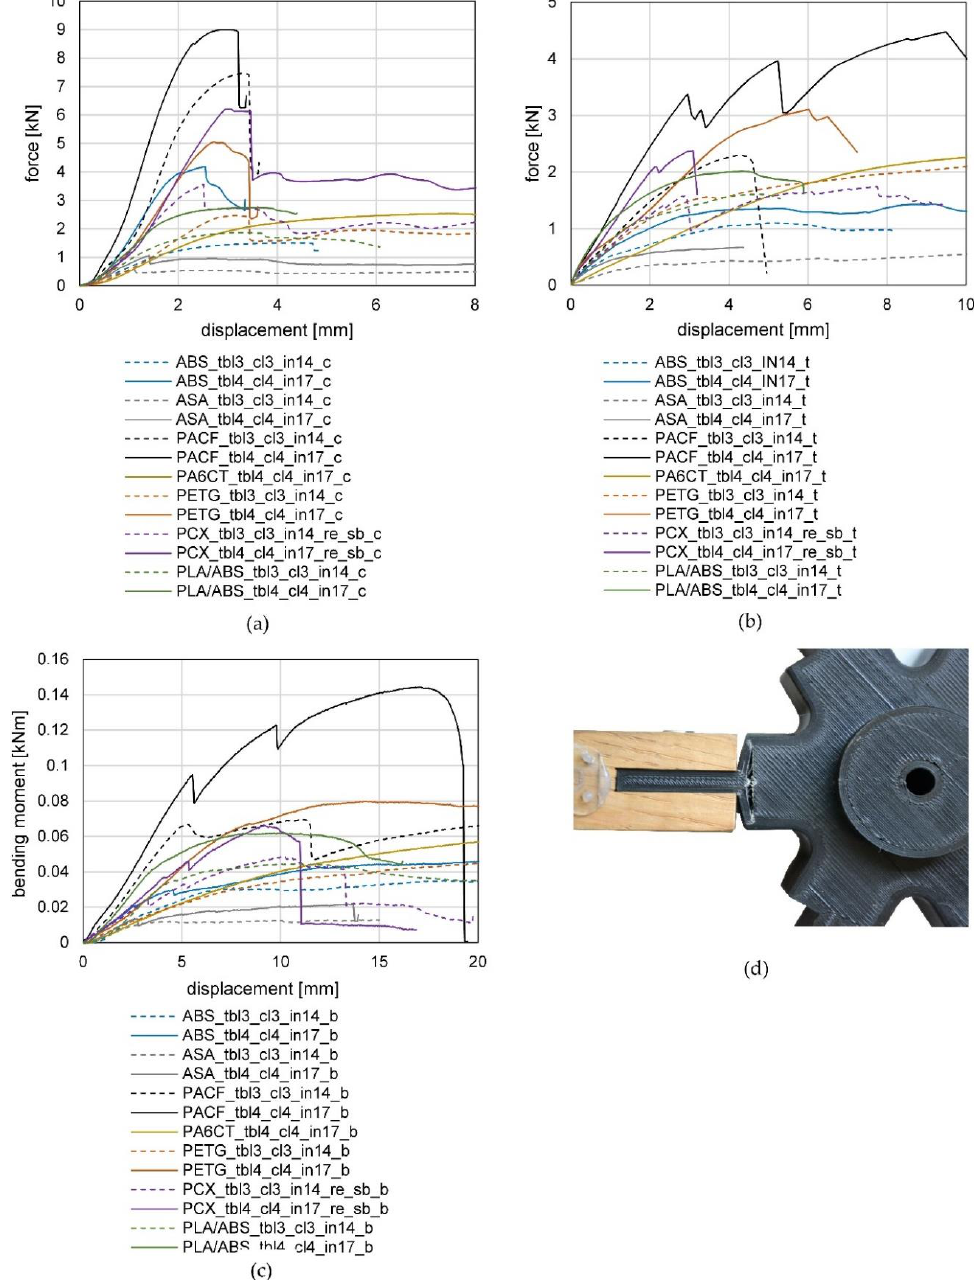
Figure 8. Results of the ( a ) compression tests; ( b ) tension tests; ( c ) bending tests, of series 1 and ( d ) tension failure caused by a loosening from the contour layers from the infill.